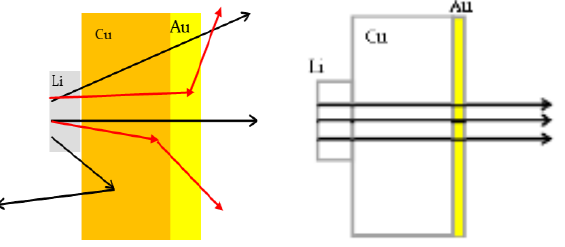
Figure 3: Left: scheme of some possible neutron scattering effects in a real experiment. Right: ideal activation